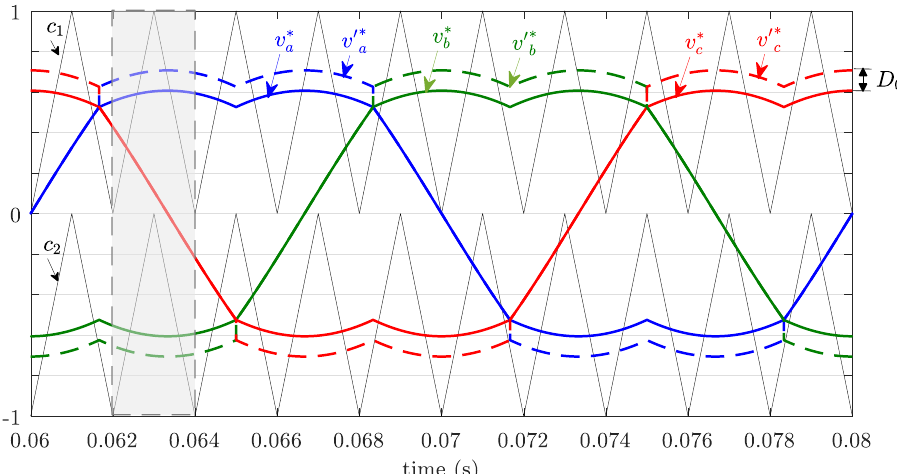
Figure 4. Modulating and carrier signals for one fundamental cycle, where m = 0.7, D 0 = 0.1, and m f = 10.